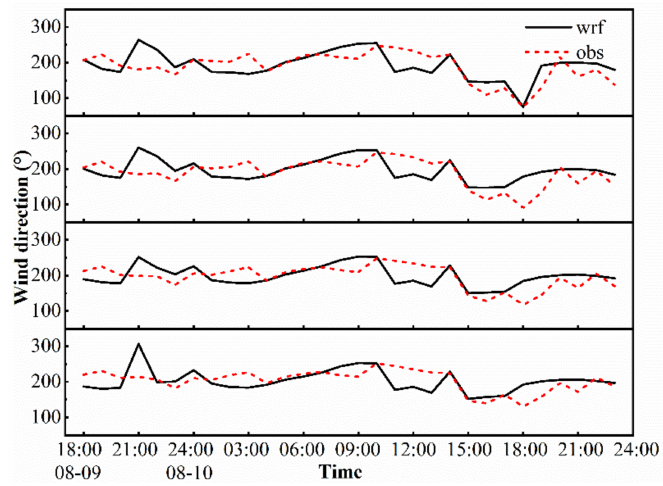
Figure 7. WRF simulated wind direction and observed wind direction at different heights (9 m, 18 m, 36 m, 54 m from top to bottom).